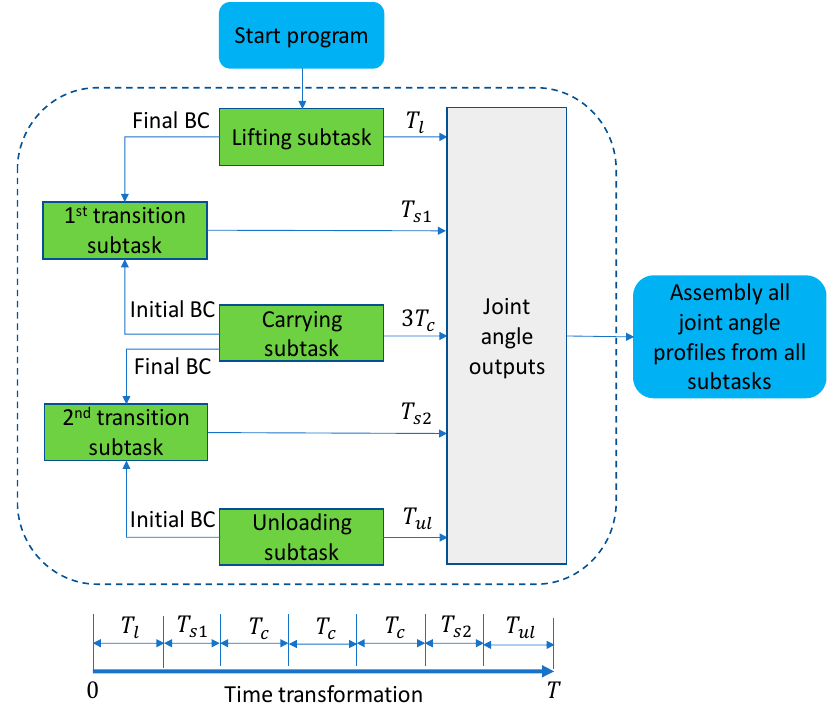
Figure 3. Flow chart of the subtask-based formulation (where BC denotes boundary conditions including joint angle and angular velocity, T l is lifting time duration, T s 1 is 1st transition time duration, T c is carrying time duration, T s 2 is 2nd transition time duration, T ul is unloading time duration, T is total box delivery time duration).